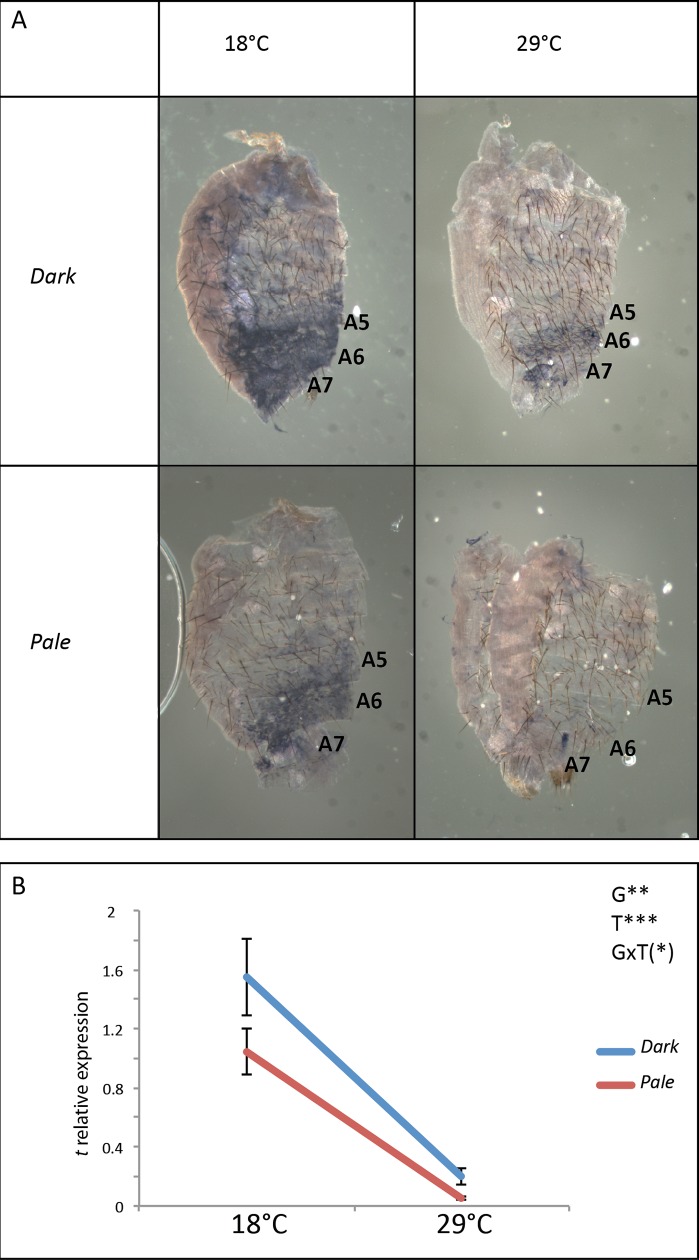
Expression of t is different between the Dark and the Pale lines and is modulated by temperature.A: in situ hybridization to reveal t expression in A5, A6 and A7 segments of Dark and Pale females grown at 18°C or 29°C. The dorsal side of the cuticle is on the right. B: RT-qPCR quantification of t expression in the posterior abdominal epidermis (A5, A6 and A7 segments) of young adult females of the Dark and Pale lines raised at 18°C or 29°C. The expression of t was normalized with the geometric mean of Act5c and RP49 expression. Error bars represent standard deviations (3 replicates of 50 individuals per condition). Statistics: ANOVA. G: effect of the genotype; T: effect of the temperature; GxT: effect of the interaction between the genotype and the temperature. (*): 0.05<p<0.1; **: 0.001<p<0.01. ***: p<0.001.